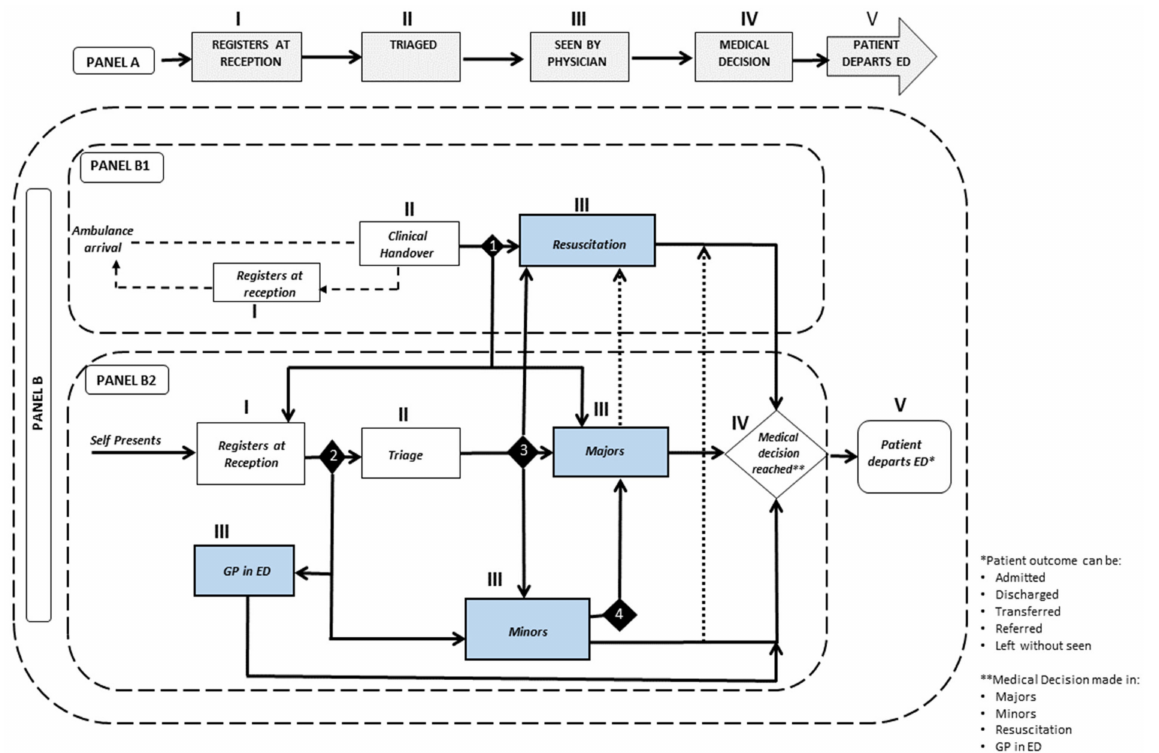
Figure 1. Flowchart of emergency department patient flow. Note: GP-general practitioner (primary care